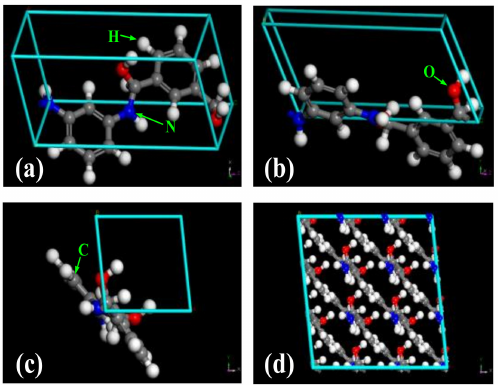
Figure 1. Meta-aramid fiber crystal model. ( a ) and ( b ) Side views of the unit cell in the meta-aramid fiber crystalline area, ( c ) front view of the unit cell in the meta-aramid fiber crystalline area, and ( d ) front view of the